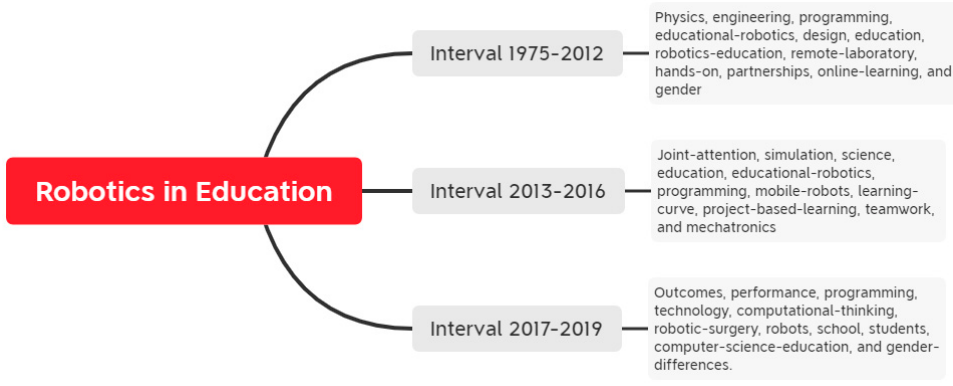
Figure 4. Synoptic representation of the evolution of robotics in education in the lines of research.